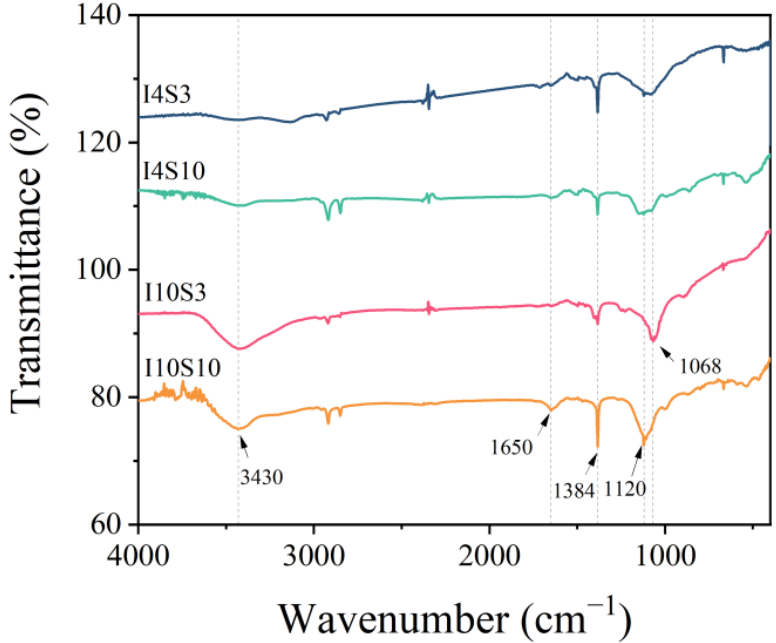
Figure 6. FTIR spectra of specimens recycled from NaCl electrolyte.